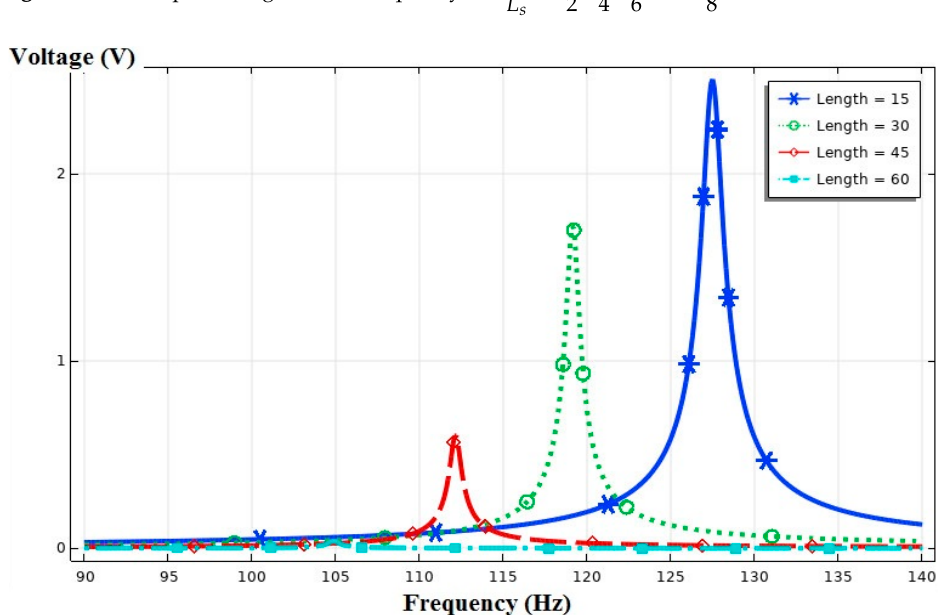
L p 1 1 1 1 = 2, 4, 6, and 8. Figure 9. The output voltage vs. the frequency for (cid:3013) (cid:3291) = (cid:2869) , (cid:2869) , (cid:2869) , and (cid:2869) . (cid:3013) (cid:3291) L s (cid:3013) (cid:3294) (cid:2870) (cid:2872) (cid:2874) (cid:2876) = (cid:2869) , (cid:2869) , (cid:2869) , and (cid:2869) . (cid:3013) (cid:3294) (cid:2870) (cid:2872) (cid:2874) (cid:2876)